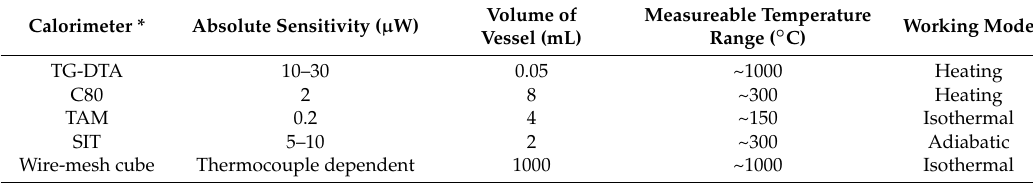
Table 1. Working modes and test conditions of the calorimeters employed in this